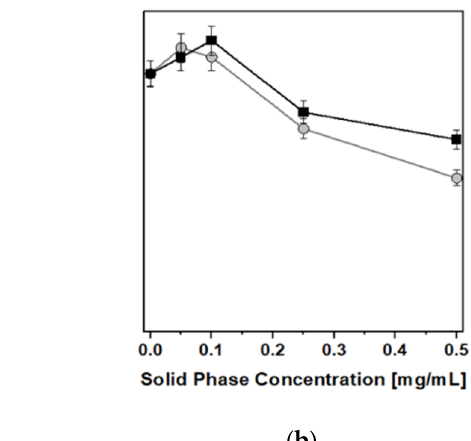
9 of 16 Figure 7. Normalized Cs + concentration in gastric fluid after contact with PB_Syn ( ■ , a ) and PB_Acid ( ● , b ) samples. A break from 6 h to 21 h is reported in the graph. PB after 24 h of contact with a gastric fluid simulant (Figure 7, curve b) was able to remove the same amount of Cs + (i.e., 98%) as the non-treated Prussian blue sample (Figure 7, curve a). Only a slight decrease in the caesium capture ability was observed in the first 3 h of test. However, the changes in the physicochemical properties observed over the PB_Acid sample did not lead to significant changes in terms of the ability of PB to remove Cs ions from a simulated enteric fluid, after a simulated transit through the gastric tract. Such results suggest a good stability of the optimized PB material against attacks under strongly acid conditions.